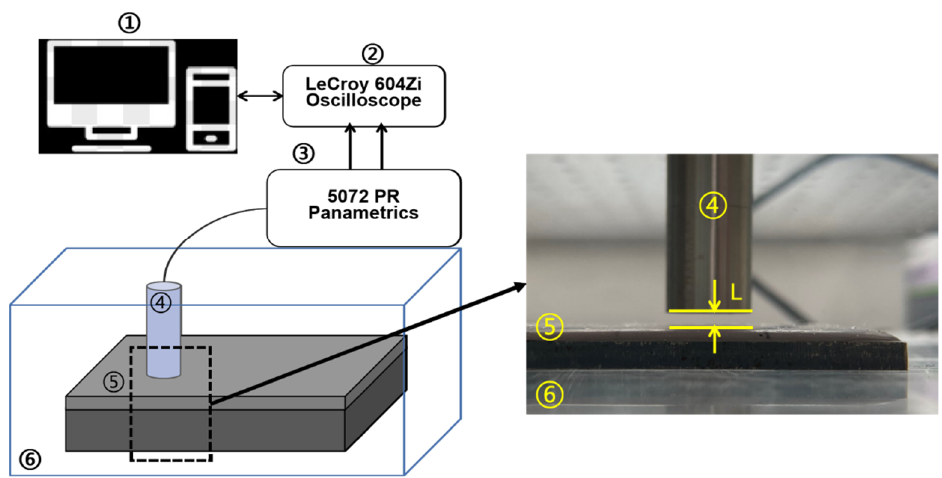
Figure 3. Experimental setup: (1) Computer; (2) Lecroy oscilloscope; (3) Pulser receiver; (4) Piezo electric immersion transducer; (5) Specimen and (6) Water tank .